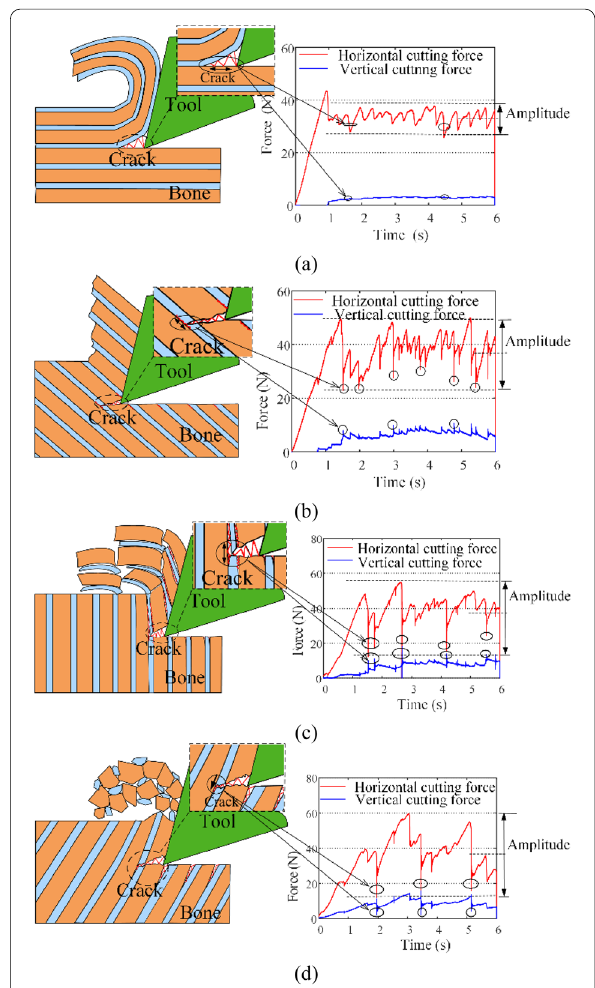
Figure 15 Crack propagations and cutting forces when the depth of cut was set as 130 μm: a Mode #1, b Mode #2, c Mode #3, d Mode